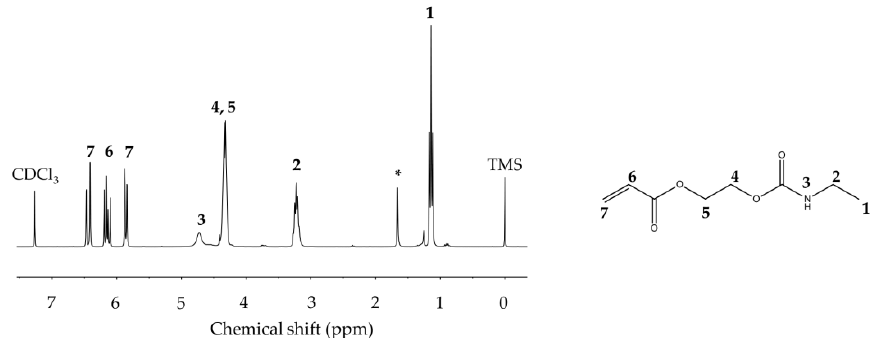
Figure 5. 1 H NMR spectrum of AU monomer.